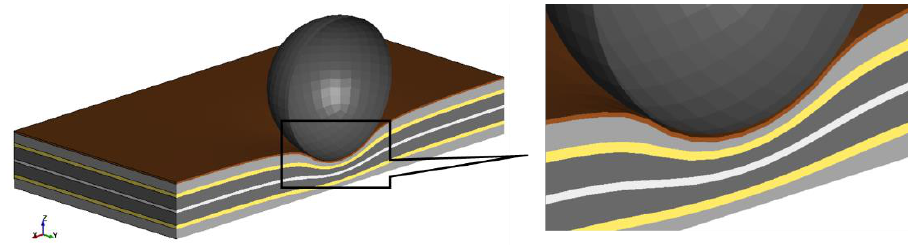
Figure 16. Simulation of a spherical indentation test for a battery cell using a sandwich modelling strategy.